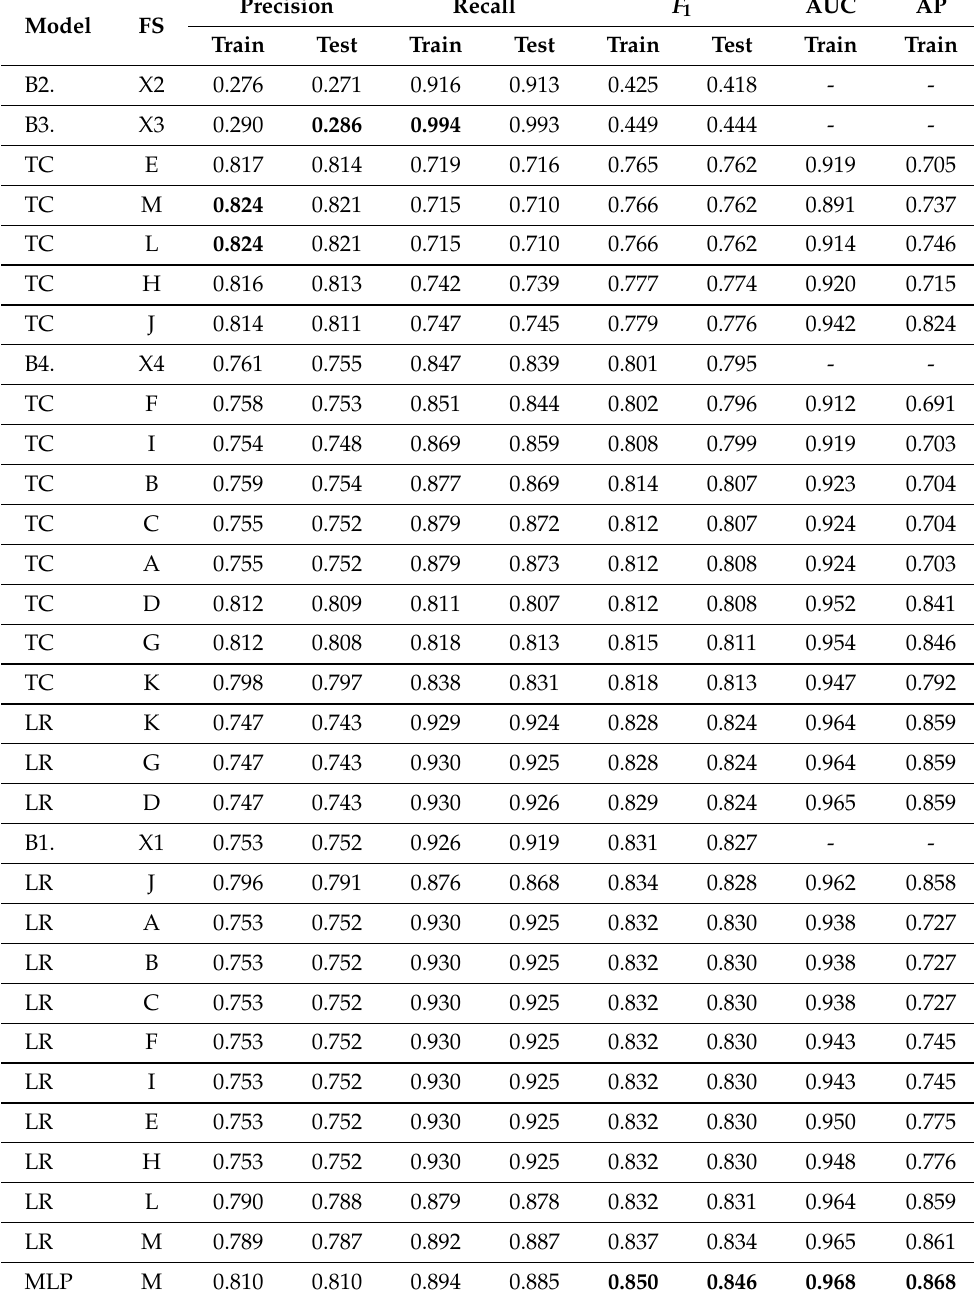
Table 6. Evaluation scores of the record linkage classifiers, sorted by ascending values of F 1 on testing subsets. The best values of each statistic are in bold. Abbreviations: B1-4 baselines, TC threshold-base classifier, LR logistic regression, MLP multi-layer perceptron, FS feature subset, AUC area under the ROC curve, AP average